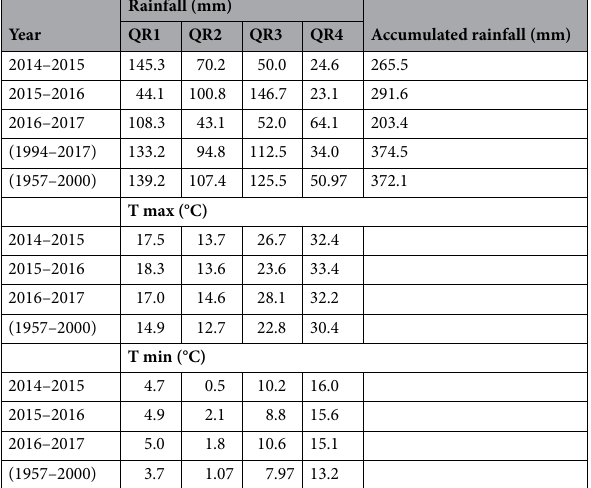
Table 1. Seasonal and accumulate rainfall (mm), and max and min average temperatures during 3-years-study and historical values. QR1 = (Oct–Nov–Dec); QR2 = (Jan–Feb–Mar); QR3 = (Apr–May–Jun); QR4 = (Jul–Aug– Sep). QR quarterly, T